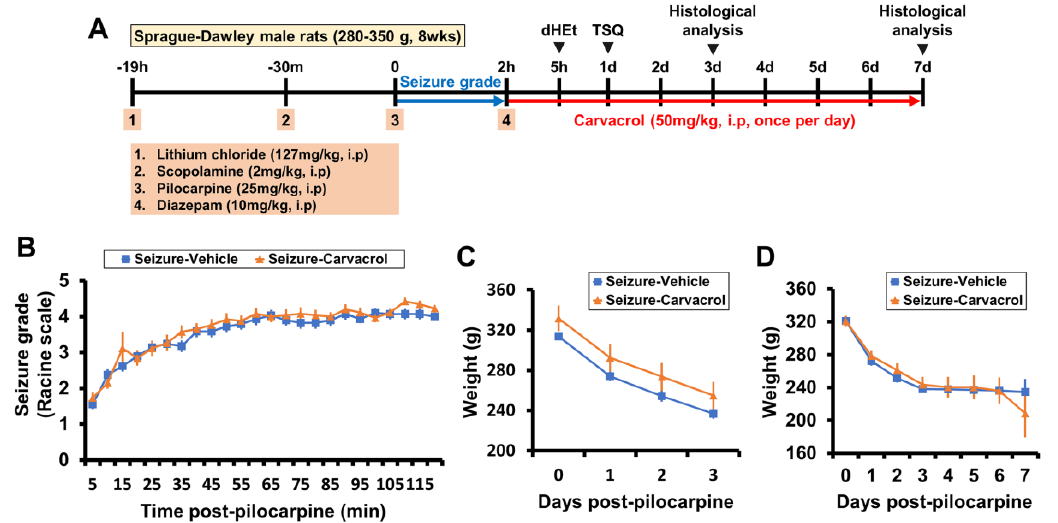
Figure 1. Carvacrol did not affect body weight following pilocarpine-induced status epilepticus (SE). ( A ) Timeline showing the experimental procedures. SE was induced by lithium-pilocarpine injection. Carvacrol was intraperitoneally administered once per day for all experimental periods. ( B ) Line graphs showing the seizure grade based on the Racine stage during SE induction by pilocarpine (mean ± SEM; n = 26–29 per group). ( C , D ) Graphs representing the weight change for 3 ( C ) or 7 days ( D ) after SE (mean ± SEM; n = 8–10 per group).